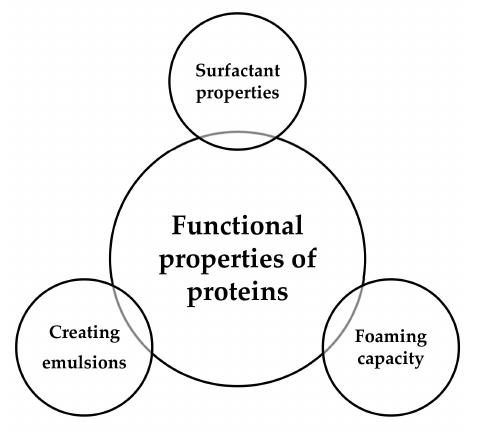
Figure 2. Classification of the main functional properties of